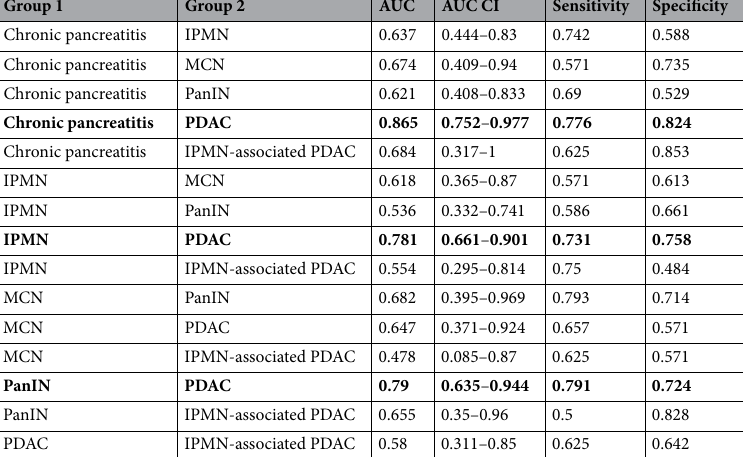
Table 3. Subject-wise classification results between the six pancreatic diseases using GaWRDenMap. The rows highlighted in bold indicate classification AUCs that are identified as significant, with 0.75 selected as the threshold value for significance. This value was determined after analysing the results as a whole and on consultation with the physician.